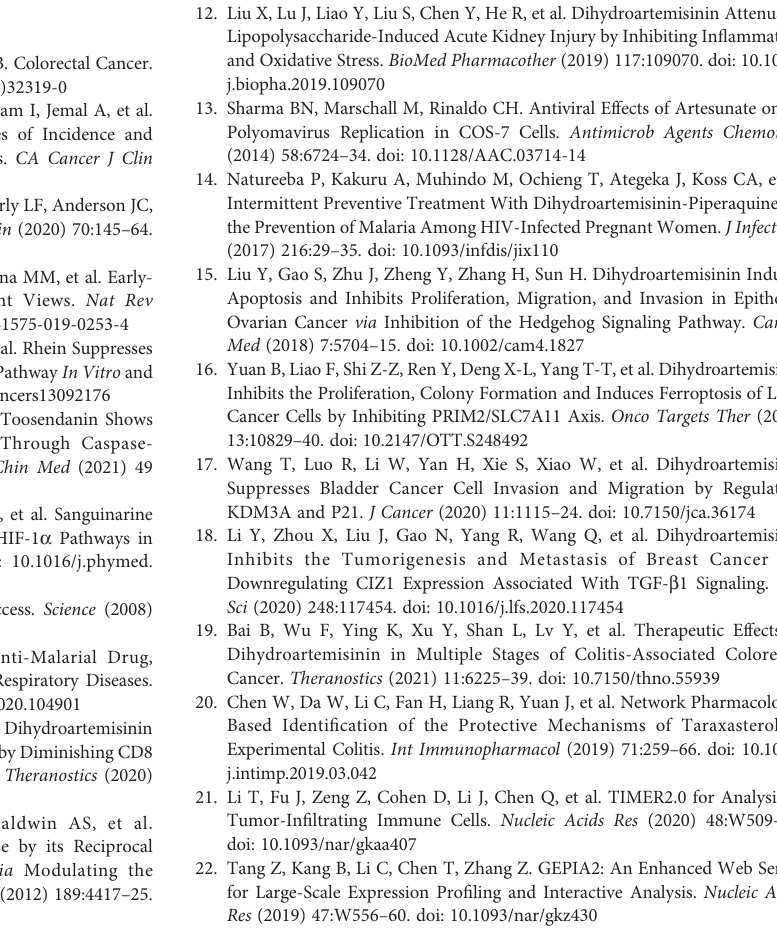
Supplementary Figure 2 | Expression levelsofCDK1, CCNB1, andPLK1 in CRC and GSEA analysis of the enriched signaling pathways. (A) The expression of CDK1, CCNB1,andPLK1inCOADandREADwereanalyzedaccordingtoTCGAandGTEx databases. (B) The total protein expression of CDK1, CCNB1, and PLK1 were analyzed in COAD through the CPTAC dataset. (C) GSEA analysis of the enriched signaling pathways by these three genes. *P < 0.05, **P < 0.01, ***P <